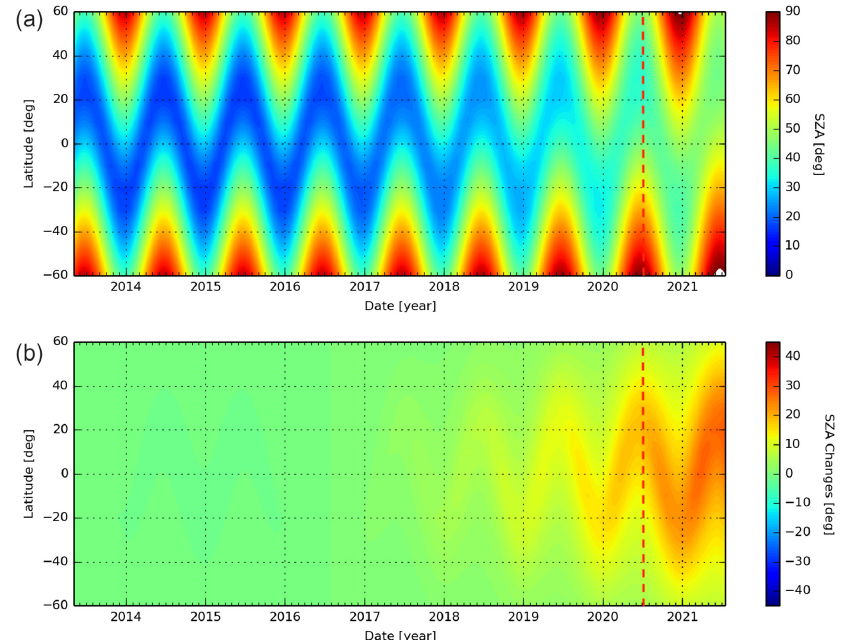
Figure 4. The figure shows ( a ) the estimated evolution of SZA from launch (7 May 2013) up to July 2021 as a function of the dates and latitude; ( b ) the absolute changes of SZA with respect to a steady orbit having a fixed overpass time, corresponding to the one reached after launch, 10:45 a.m. The end of Proba-V Operational Phase (30 June 2020) is plotted as a dashed red line.